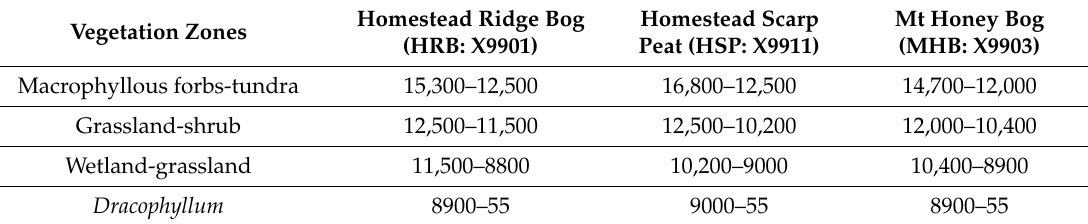
Table 1. Pollen vegetation zonation (periods calibrated years